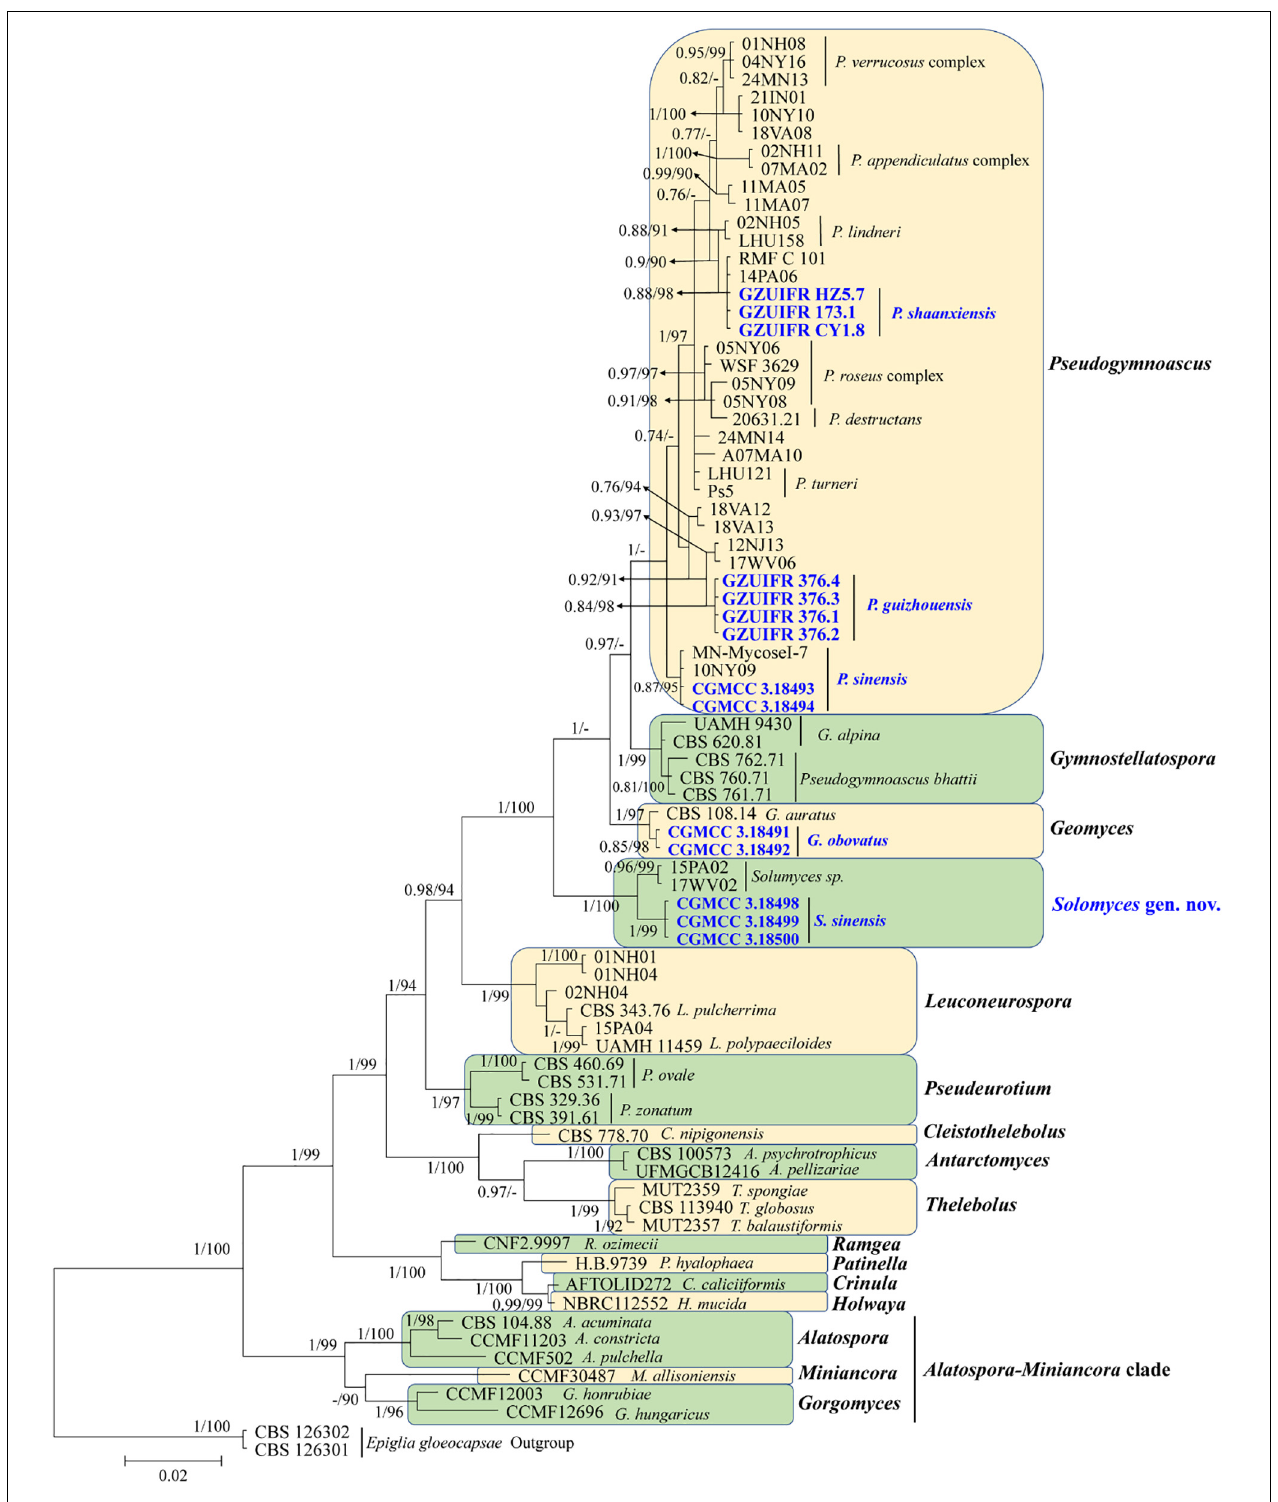
FIGURE 1 | Phylogenetic relationships among the genera in Thelebolales based on Bayesian inference and maximum-likelihood analyses of the concatenated internal transcribed spacers (ITS) and LSU dataset. Posterior probabilities ≥ 0.7 and maximum-likelihood bootstrap values ≥ 90% are shown above the internal branches. The new isolates are presented in bold and